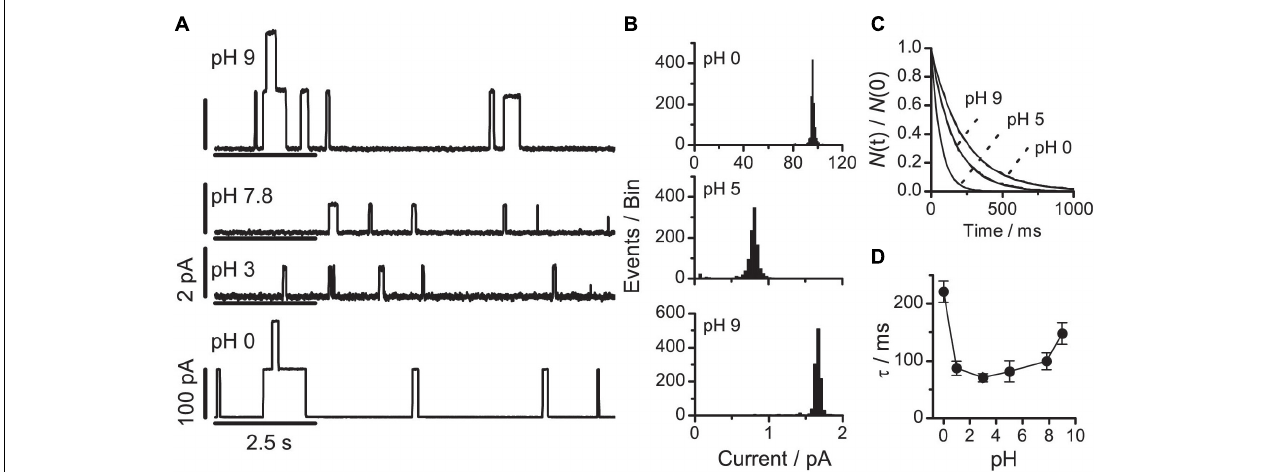
FIGURE 6 | VgA(15) channel function in DOPE:DOPC(4:1)/ n -decane bilayers at different pHs (A) single-channel current traces at pH: 9, 7.8, 3, or 0. The current calibration bars are 2 pA at pH 9, 7.8 and 3, and 100 pA at pH 0. (B) Current transition amplitude histograms at pH 9; 5 or 0 (results from single experiments). (C) The corresponding normalized single-channel duration histograms: at pH 9 ( τ = 162 ms); at pH 5 ( τ = 65 ms); and at pH 0 ( τ = 235 ms). Results from single experiments fitted by single exponential distributions. (D) Relation between pH and channel lifetime (mean ± SD, n ≥ 3). 0.1 M NaCl buffered with 10 mM Gly-Gly or Na 2 HPO 4 , 200 mV, 100